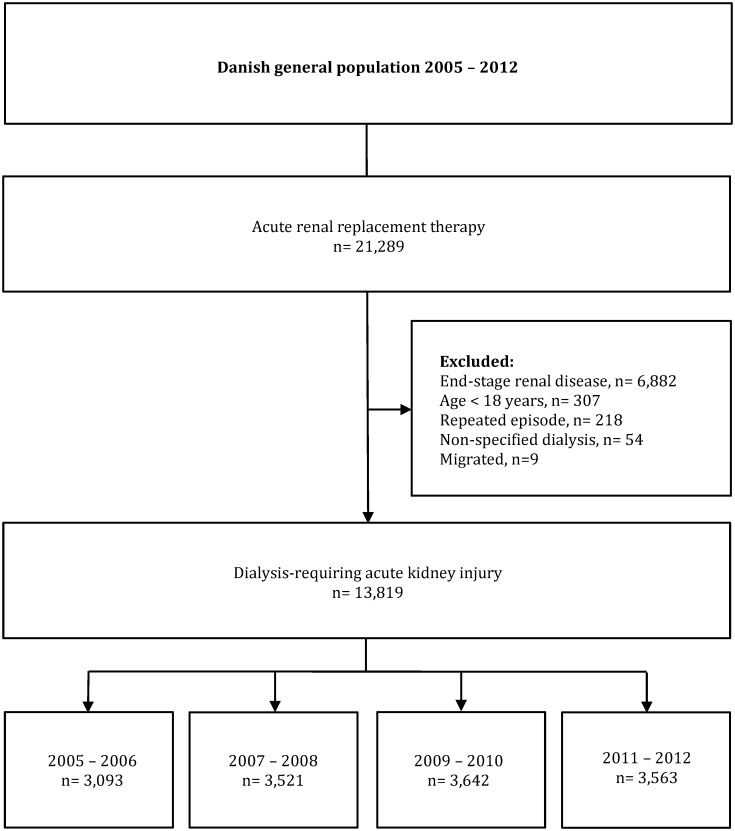
Flow chart depicting study design.